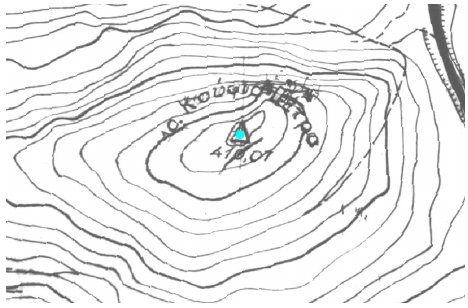
Figure 4. A trigonometric point on the map which is used as CP.